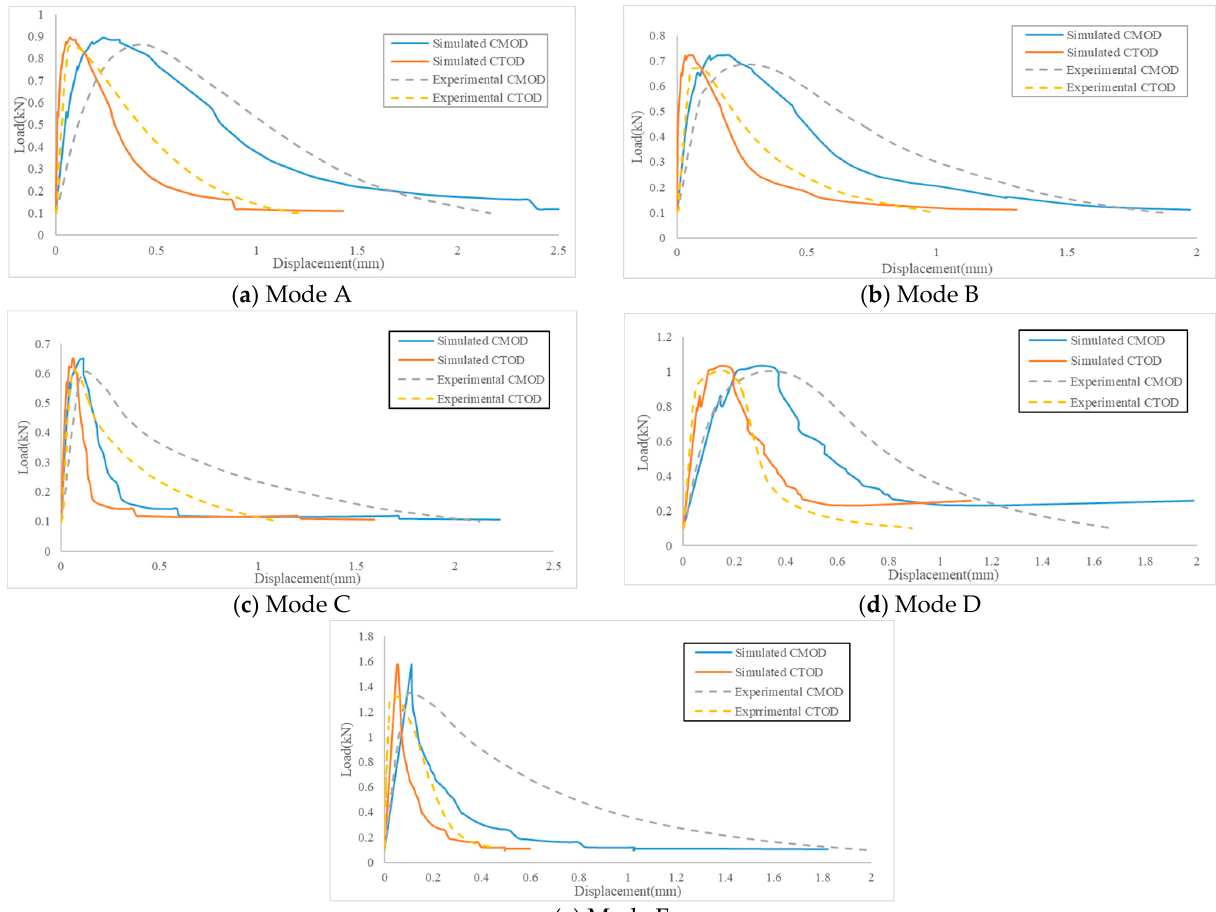
Figure 7. Comparison of simulated results and experimental results of the CR-20 mixture with 40 mm notch under five kinds of mixed-mode